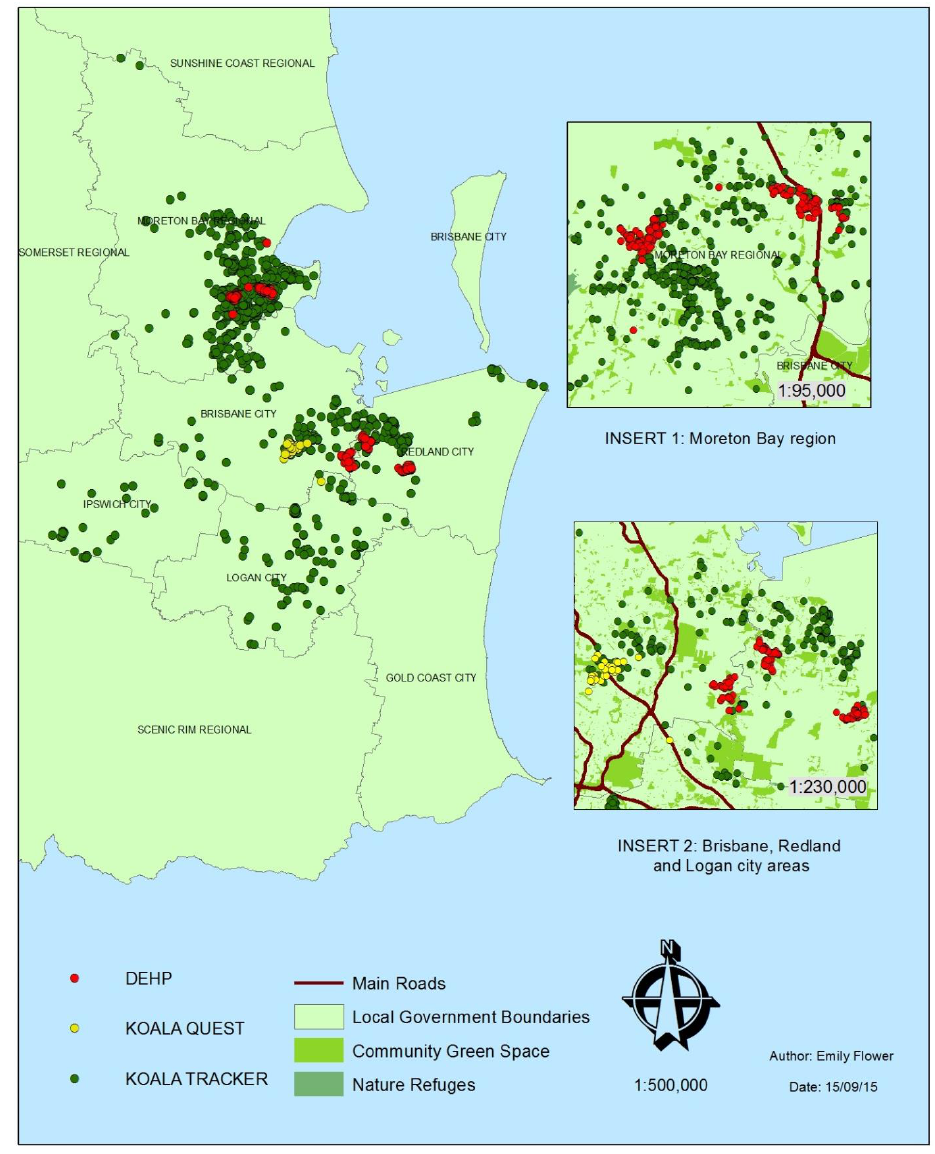
Figure 2. Data source comparison—Koala Quest, Department of Environment and Heritage Protection (DEHP), and Koala Tracker.